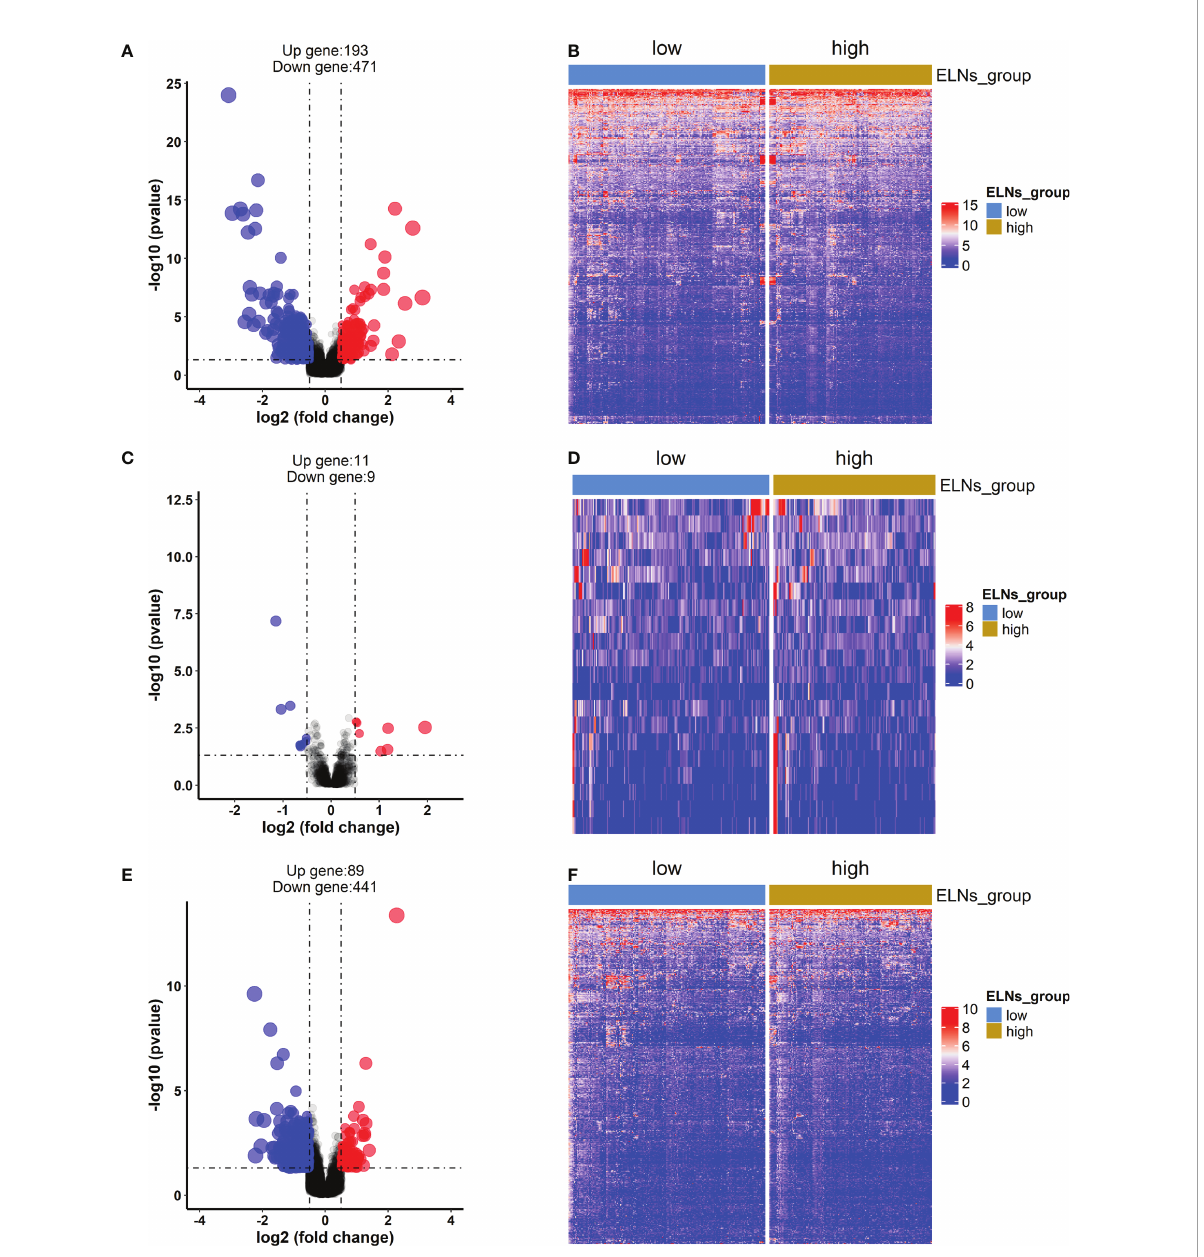
FIGURE 7 The differentially expressed mRNAs, lncRNAs, and miRNAs between the high-ELN and low-ELN groups were identi fi ed using the “ DESeq2 ” package with R. The cutoff that we set was log2 (foldchange) > 0.5 or < − 0.5 and p < 0.05. (A, C, E) The volcano plots of differentially expressed mRNAs (n = 664), lncRNAs (n = 530), and miRNAs (n = 20). Blue and red dots represent downregulated genes and upregulated genes, respectively. (B, D, F) Heat maps of the differentially expressed lncRNAs, miRNAs, and mRNAs between the high- and low-ELN